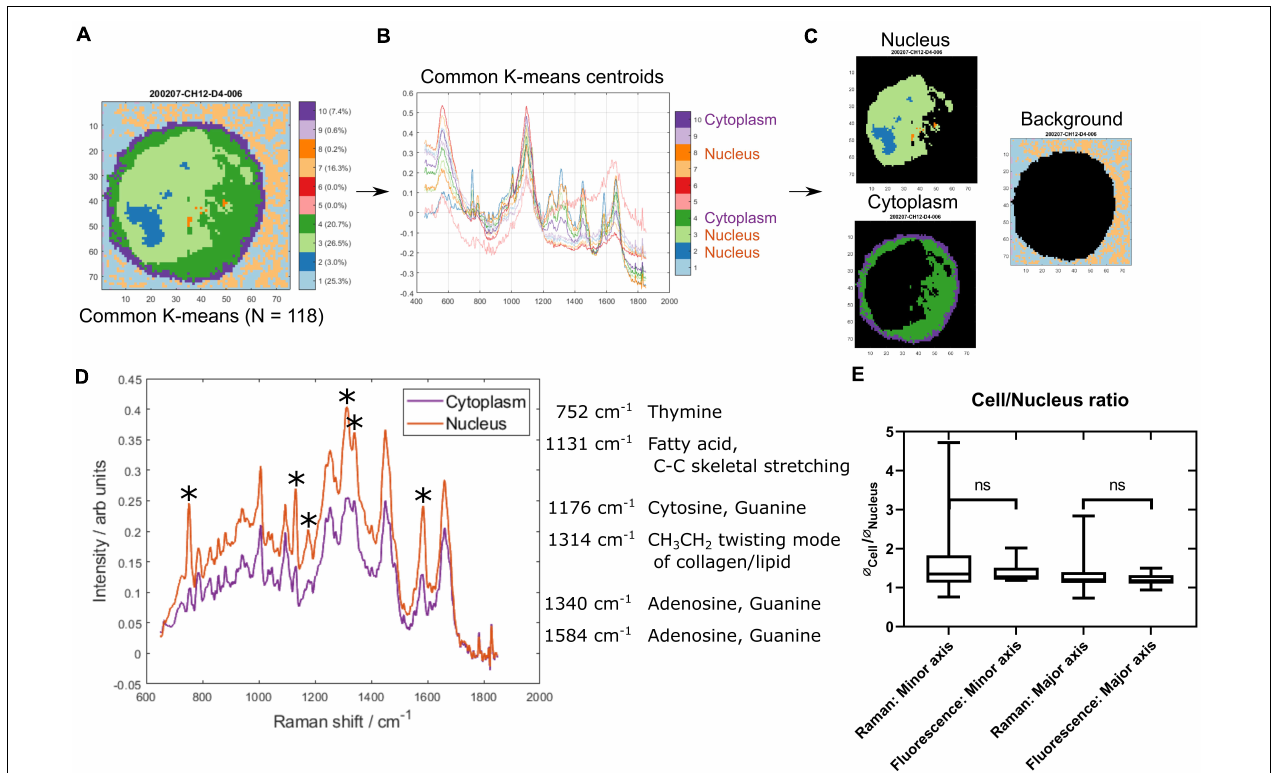
FIGURE 1 | Identifying nucleus and cytoplasm associated areas using common K-means. (A) An example cell map (specifically sample 200207-CH12-D4-006) after common K-means with 10 clusters, which was used to analyze 118 individual cell maps concurrently. (B) The 10 common K-means centroid spectra. Spectral assignments were used to identify the clusters associated with cytoplasm (4 and 10) and nucleus (2, 3, and 8). (C) Example cell map (as seen in A ) with nucleus (top left), cytoplasm (bottom left), and background (right) associated pixels highlighted. (D) Comparison of the mean cytoplasm and nucleus spectrum across all cells. The largest peak differences are highlighted and peak assignments are listed. (E) Comparison of nucleus/cell ratio between Raman maps and epifluorescence microscopy images. ∗ denotes differential peak